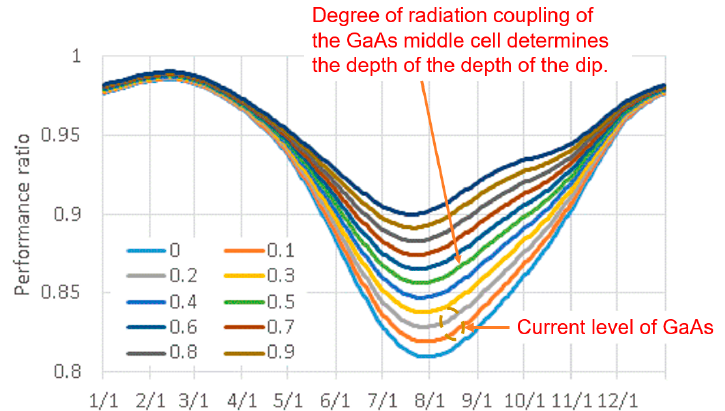
Figure 7. Recovery of the spectrum-mismatching loss due to water absorption in summer by enhancing the ratio of luminescence coupling between the middle junction and the bottom junction, added and modified from the original chart in [97]. The multiple colored lines correspond to the level of the luminescence coupling between the middle junction and the bottom junction, from the bottom to the top, 0%, 10%, 20%, ... , 90%. Please note that the variation of the performance ratio impacted by the spectrum change was reduced by the increase of the level of luminescence coupling, but the right depth in summer corresponds to the ones of 10% and 20% of the luminescence coupling. Performance ratio can be calculated by the formula defined as PR = Yf / Yr, where PR is performance ratio, and Yf is the integrated energy yield of one day, and Yr is the nominal energy yield of one day calculated by the STC module e ffi ciency and total